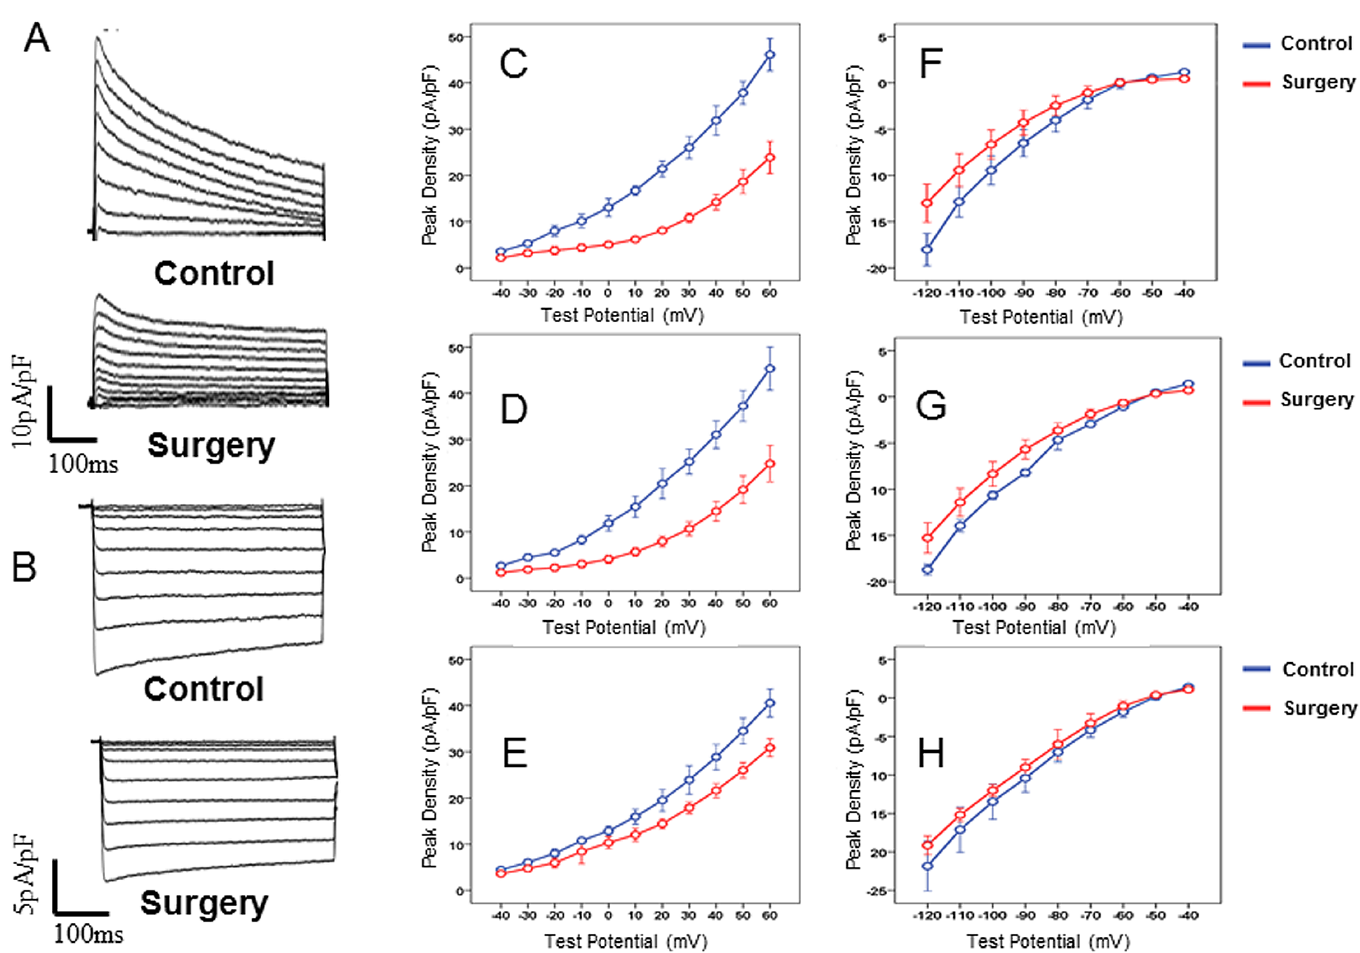
Fig 3. Recordingof outwardpotassium currents (I Peak ) (A, C, D, E) and inwardpotassium currents (I K1 ) (B, F, G, H) at different regions, including the epi- myocardium(C, F), endo-myocardium(D, G) and right ventricle(E, H) in both groups.